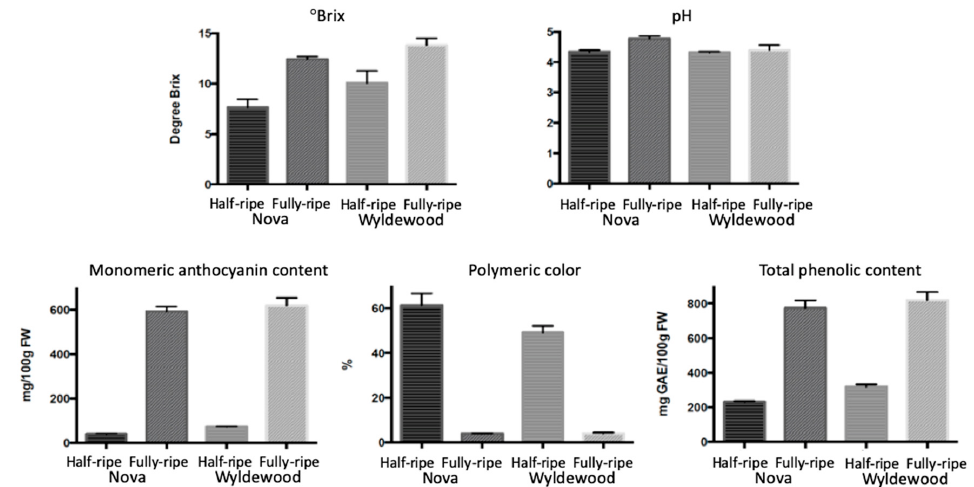
Figure 1. Comparison of ‘Nova’ and ‘Wyldewood’ fruits’ phytochemical attributes (°Brix, pH, monomeric anthocyanins, polymeric color, total phenolic content) at the half and fully-ripe stages. Results expressed as mean ± SD ( n = 3).